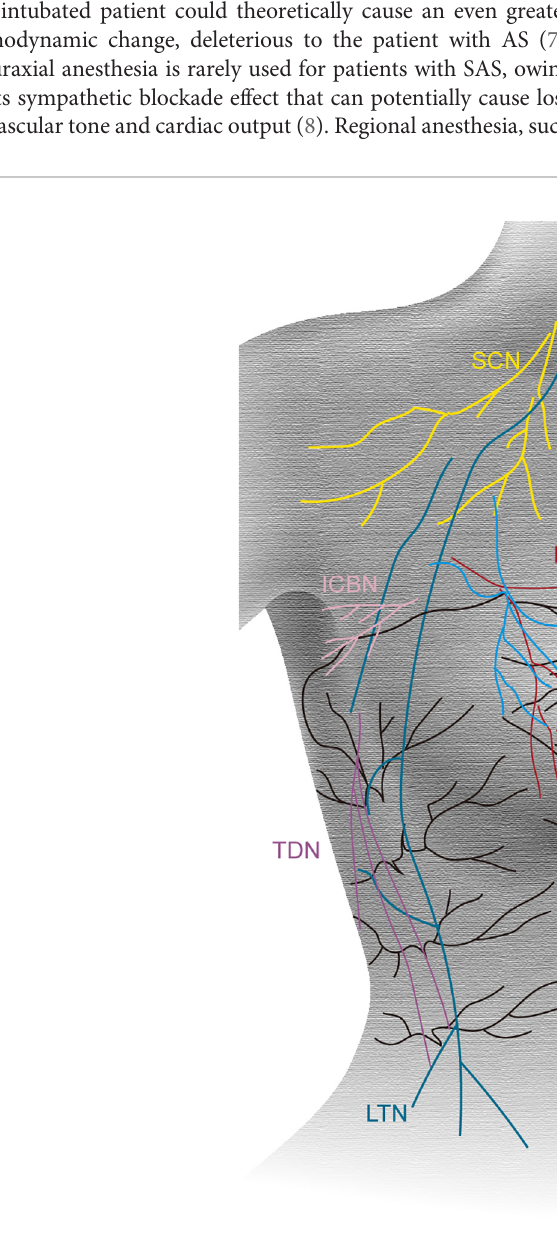
FIGURE 4 | Innervation of the breast. The supraclavicular nerves (SCN, yellow); anterior and lateral branches of the intercostal nerves (ICN, black); lateral pectoral nerve (LPN, red); medial pectoral nerve (MPN, blue); intercostobrachial nerve (ICBN, pink); long thoracic nerve (LTN, green); thoracodorsal nerve (TDN,